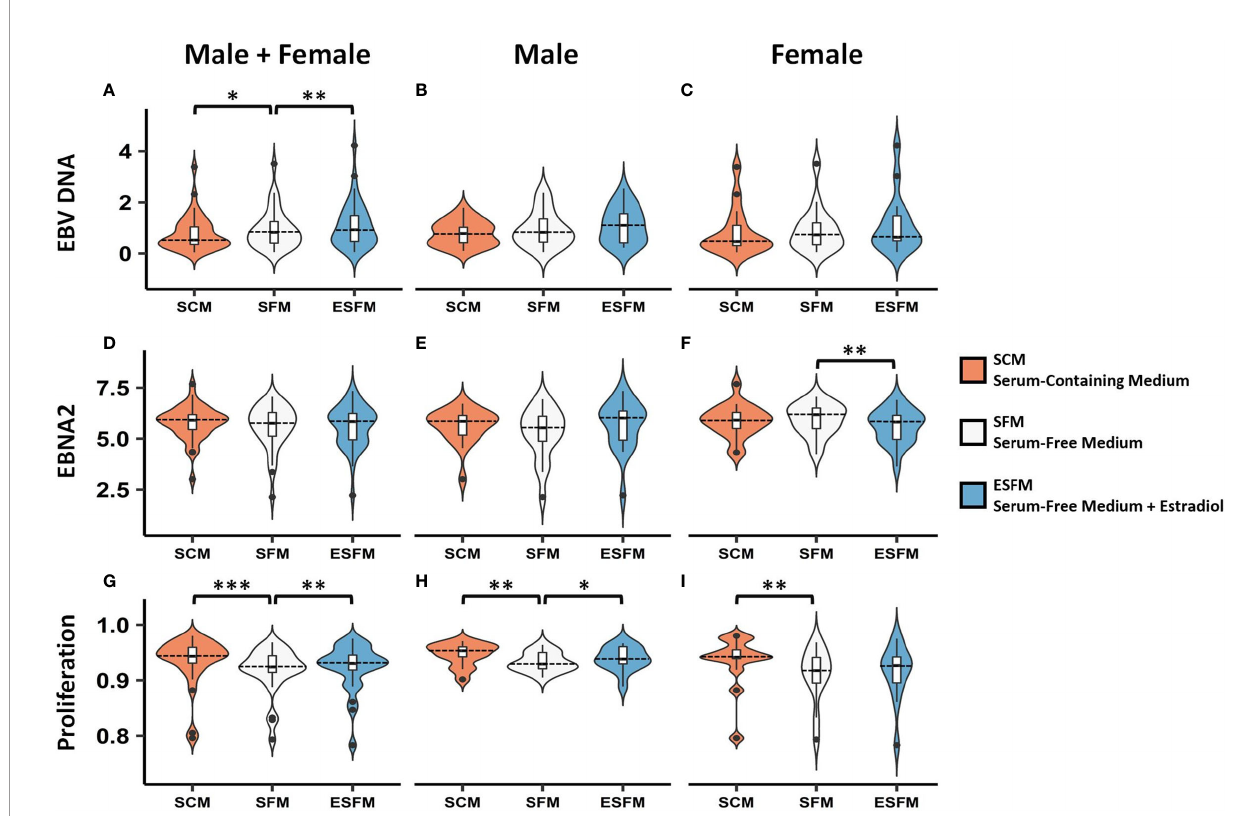
FIGURE 5 | Effect of serum depletion and estradiol treatment of LCLs on EBV latency III. Top row, EBV DNA copy number. (A) Estradiol signi fi cantly increased EBV DNA copy number in male and female LCLs combined. Both male (B) and female (C) demonstrated insigni fi cant increases in EBV DNA copy number in response to estradiol. Middle row, EBNA2 mRNA expression under different serum conditions. (D) Male and female LCLs combined, (E) Male LCLs, and (F) Female LCLs. EBNA2 expression was signi fi cantly reduced by estradiol in female LCLs. Bottom row, LCL proliferation. Removal of serum reduced proliferation in male and female LCLs combined (G) . Estradiol treatment increased cell proliferation signi fi cantly in male LCLs (H) but not signi fi cantly in female LCLs (I) . Male and female LCLs combined (n = 42), male LCLs (n = 21), and female LCLs (n = 21). EBNA2 expression detected by real-time PCR relative to RPL30 expression. Wilcoxon matched- pairs signed rank test performed (two-tailed). * < 0.05, ** < 0.01, *** < 0.001. SCM, serum-containing medium; SFM, serum-free medium; ESFM, serum-free medium with additional estradiol at a fi nal concentration of 100 nM (see Materials and Methods